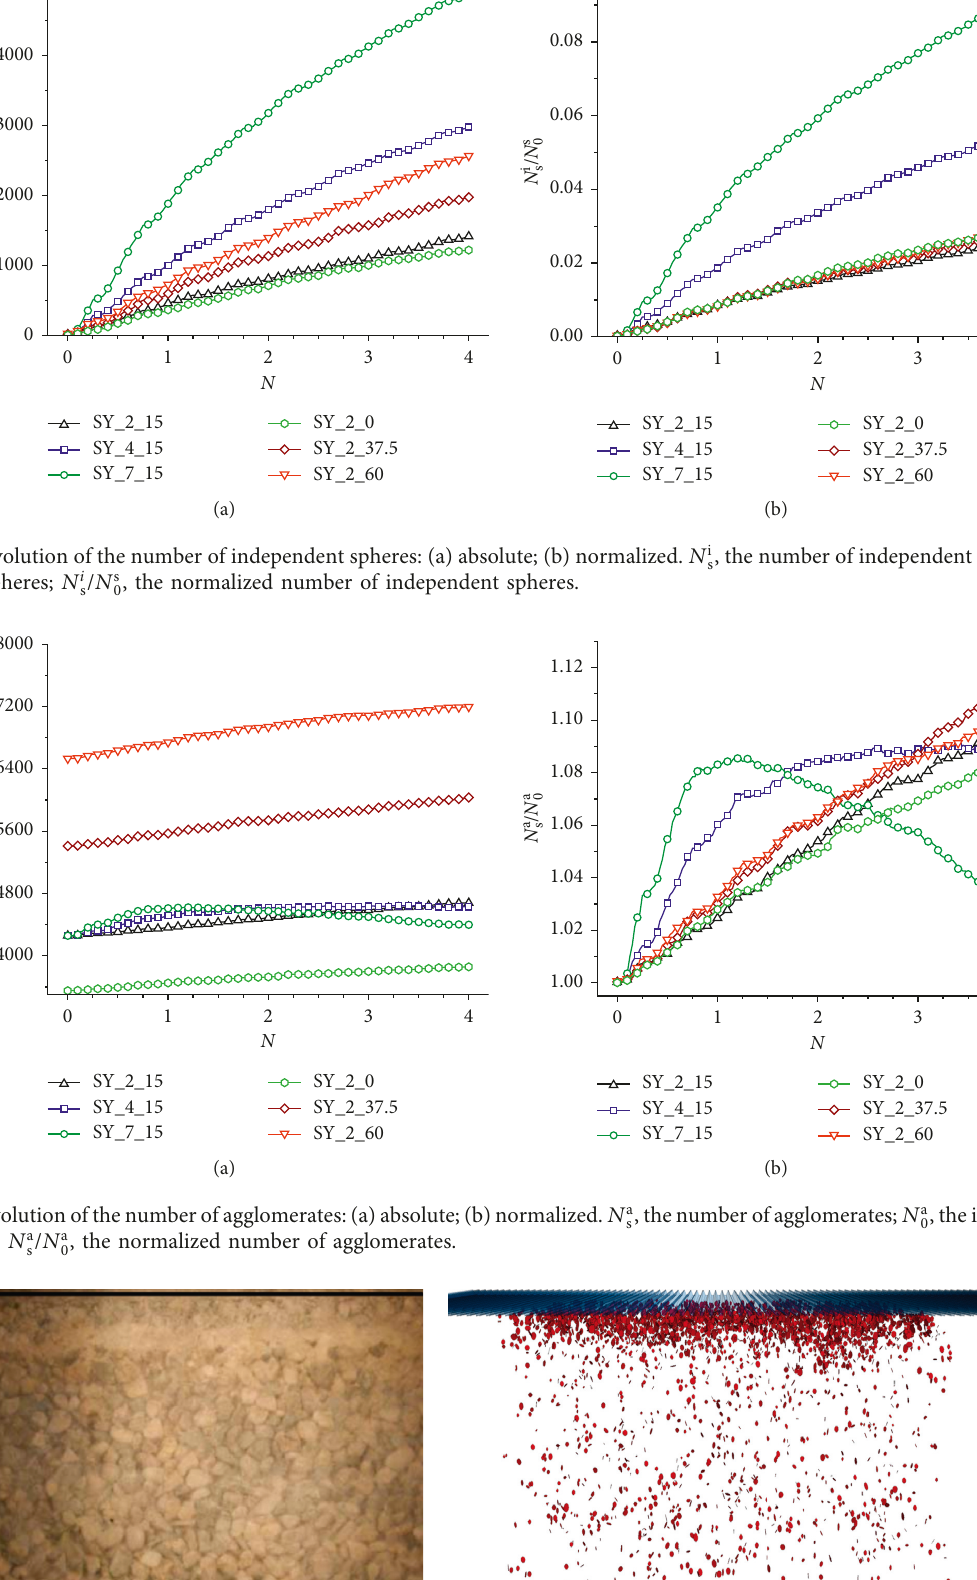
Figure 14: (a) Photograph of steel and gravel nearby under a constant normal stress of 200kPa in the end of Cycle 3 (the top black line denotes the steel, Zhang [4]). (b) Schematic view of breakage positions for SY_2_15 in the end of Cycle 3 (the red disk denotes the breakage